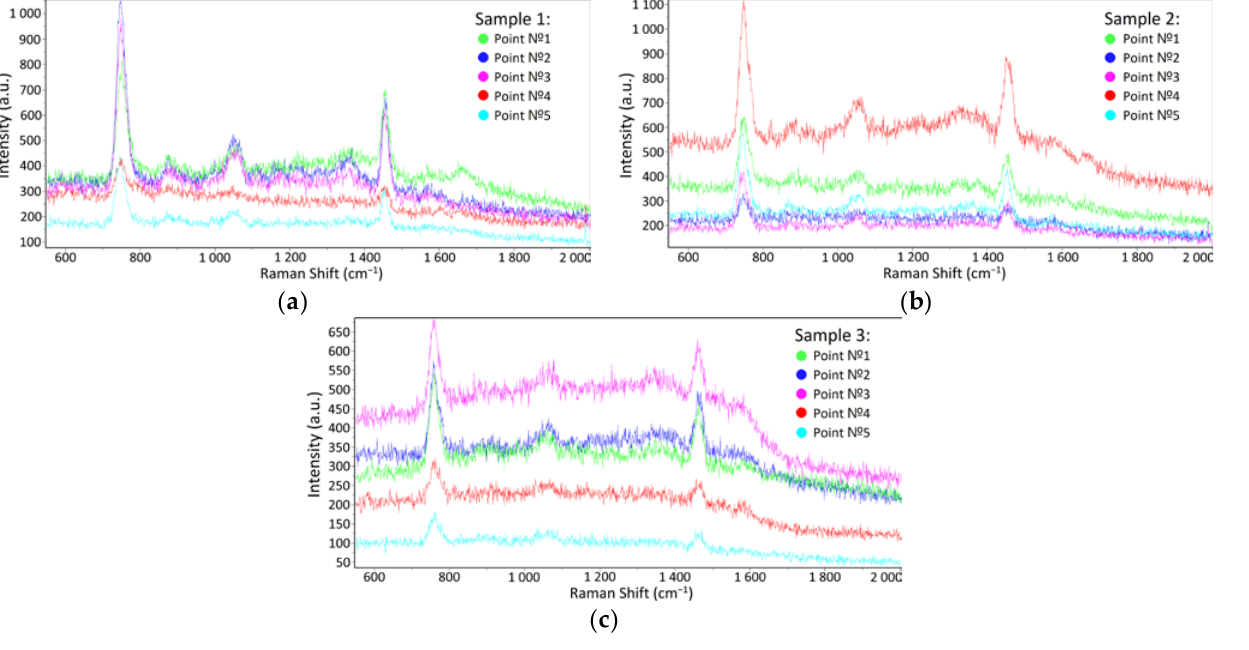
Figure 4. SERS spectra examples at different spatial points on the substrate having: ( a ) a pure buffer medium; ( b ) an influenza A virus in the buffer medium; ( c ) an influenza B virus in the buffer medium. The spectra of one sample taken at different points are indicated by different line colors.